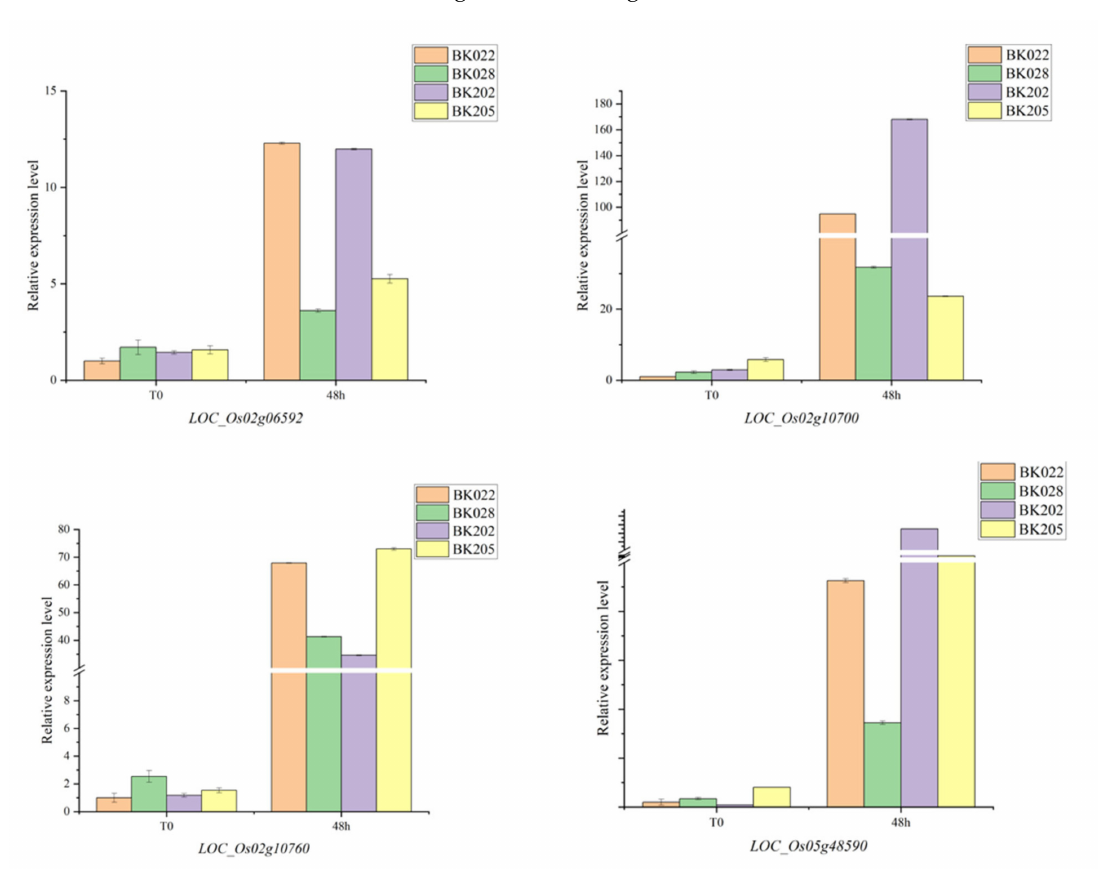
Figure 6. Expression patterns of four candidate genes. The vertical axis in each subfigures represents the relative expression level of gene, and the horizontal axis represents different treatments i.e., T0 is the control treatment and 48h is the 48h after cold treatment. Different colored columns represent different accessions of